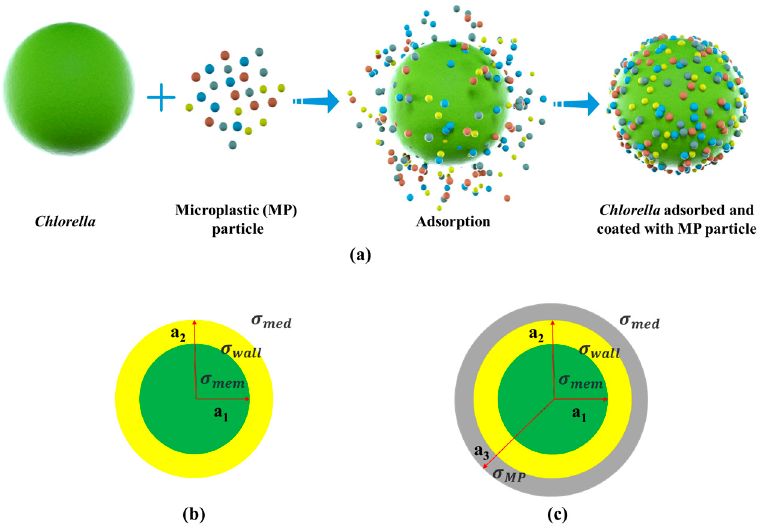
Figure 1. Schematic illustration of ( a ) the Chlorella adsorbed with microplastic (MP) particles, ( b ) the single-shell structure model of Chlorella , ( c ) the double-shell structure model of Chlorella adsorbed and coated with a layer of MP particles.